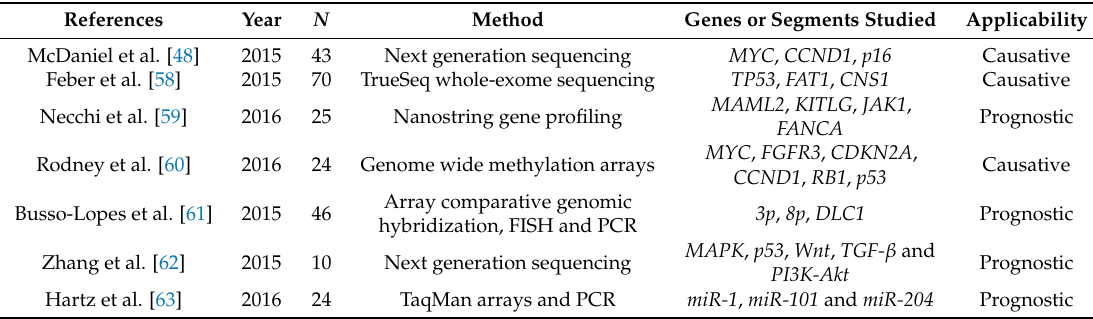
Table 2. Recent significant genomic studies in penile